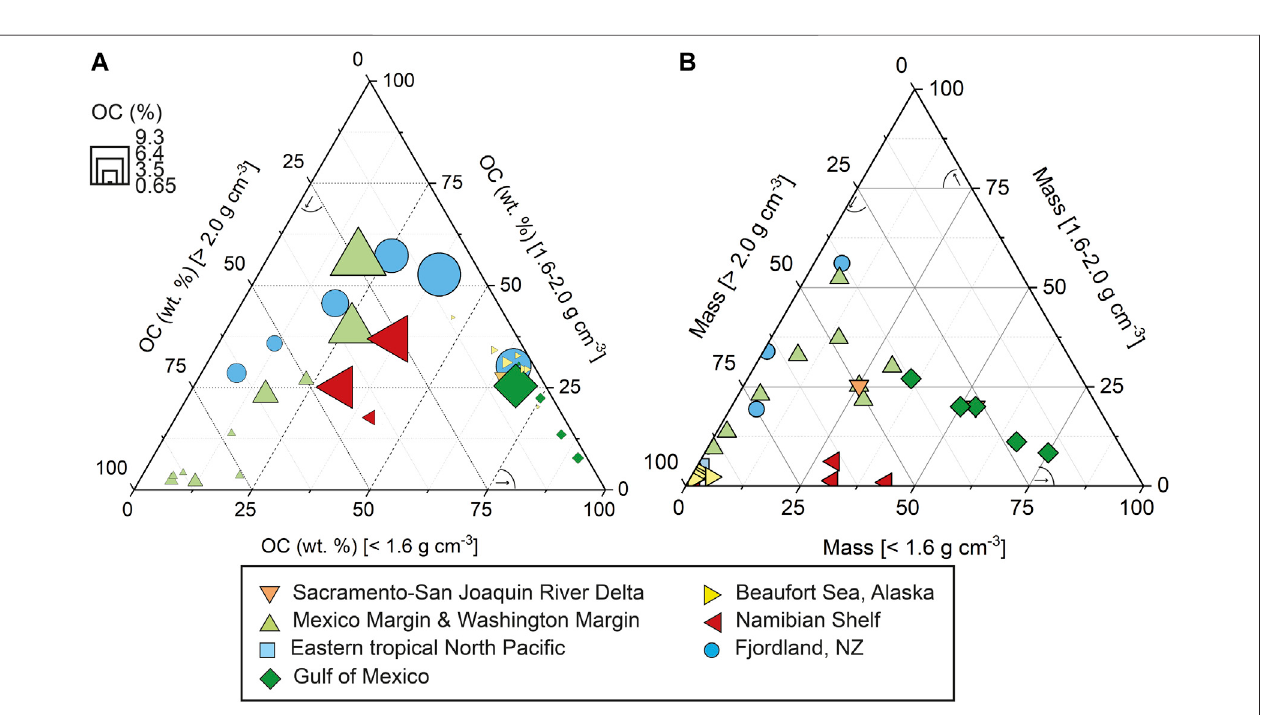
Frontiers in Earth Science |